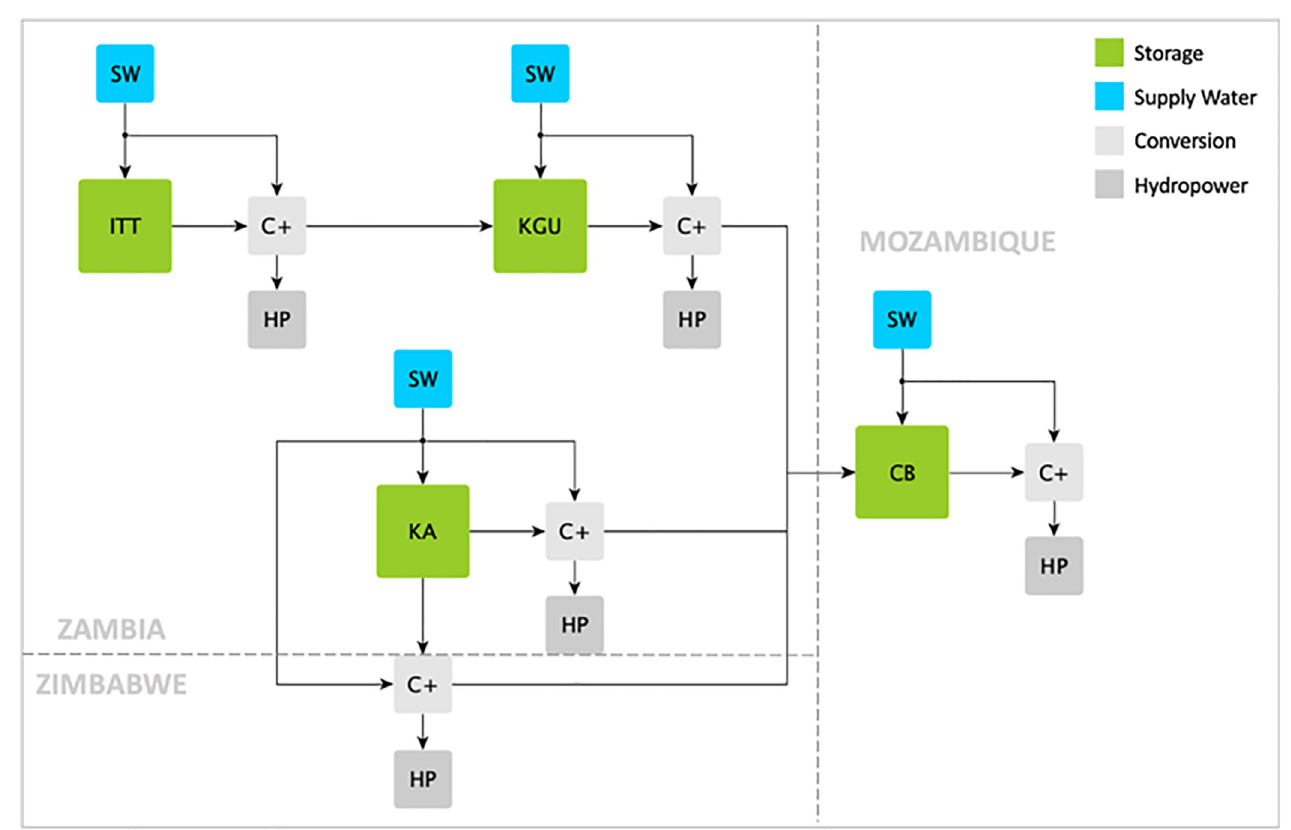
Fig 5. Zambesi River Basin (ZRB) modelling scheme within the Calliope_Hydro model.